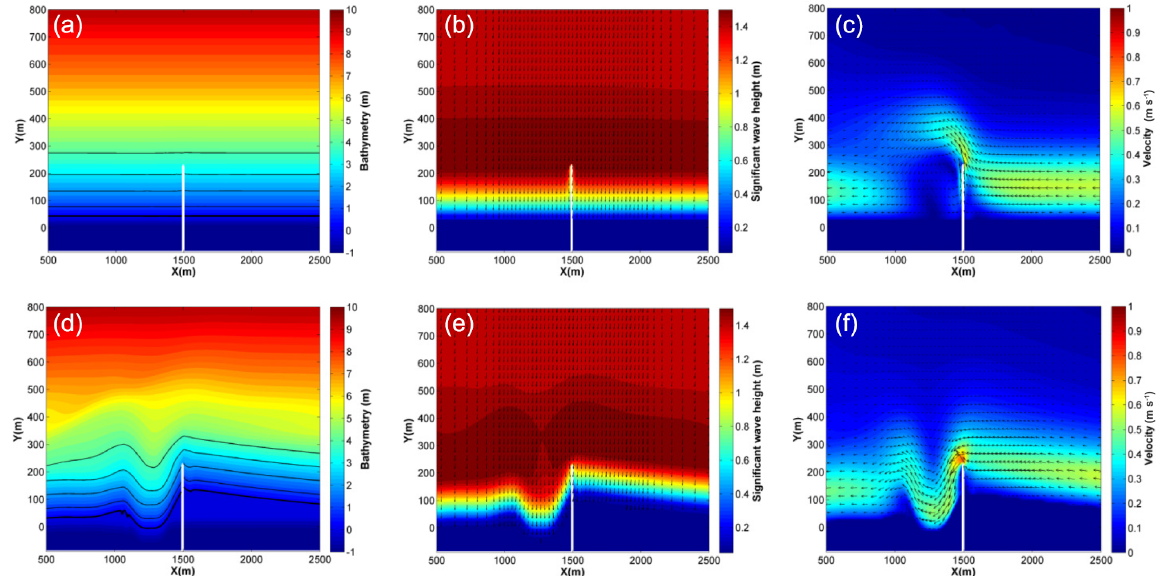
Figure 7. Groyne with a length of 200m from the shoreline. Bathymetry (a, d) , waves (b, e) , and currents (c, f) for the initial condition (a, b, c) and near equilibrium (d, e, f) after 9 years. The thicker isoline in the bathymetry represents the shoreline, whereas the others represent the 1, 2, 3, and 4m